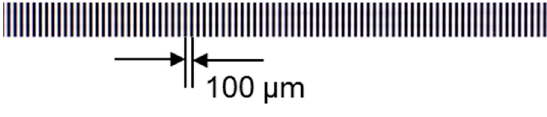
Figure 8. Enlarged details of the 100 mm pattern target.